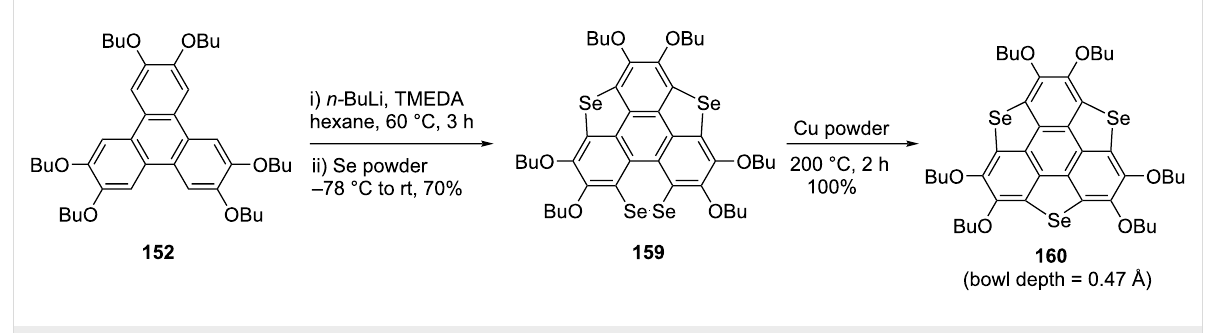
Scheme 41: Synthetic route towards hexathiolated trithiasumanenes 158 .